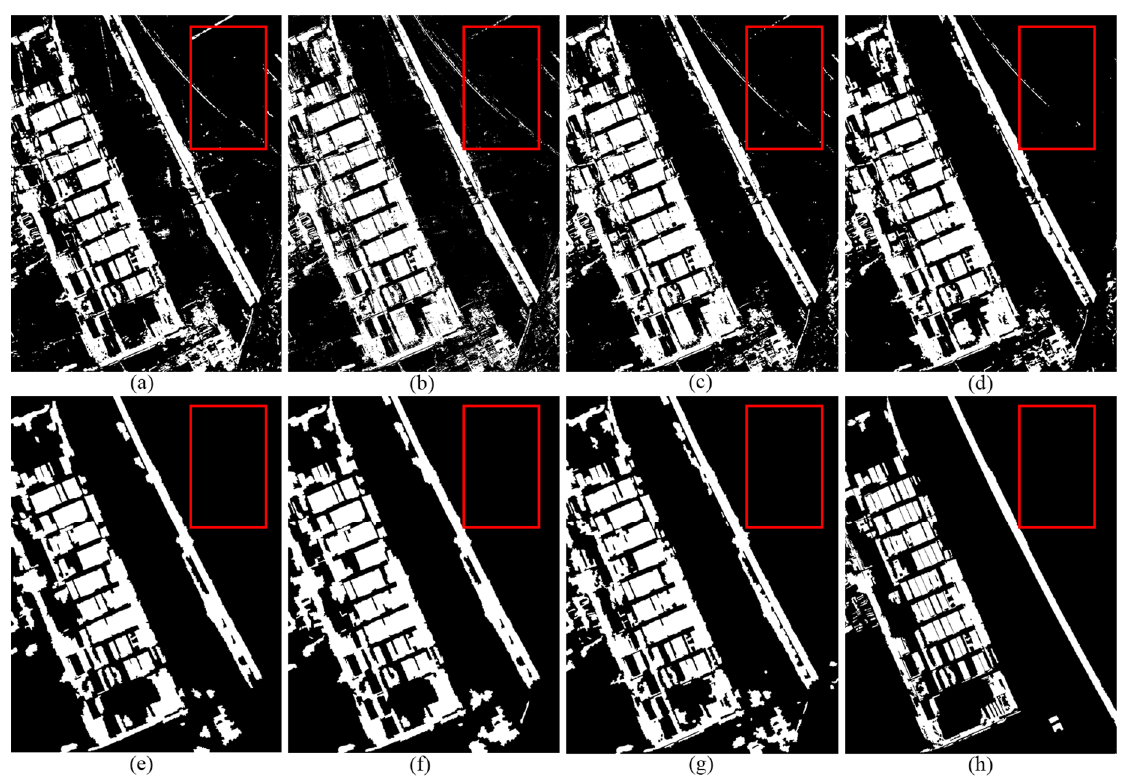
Figure 8. Change detection maps obtained for Ji’Nan QuickBird satellite images through (a) PCA_kmeans; (b) CVA_FCM; (c) Semi_FCM; (d) LSELUC; (e) Proposed_EMPs+Spectra; (f) Proposed_APs+Spectra; (g) Proposed_RGF+Spectra; and (h) ground reference map.